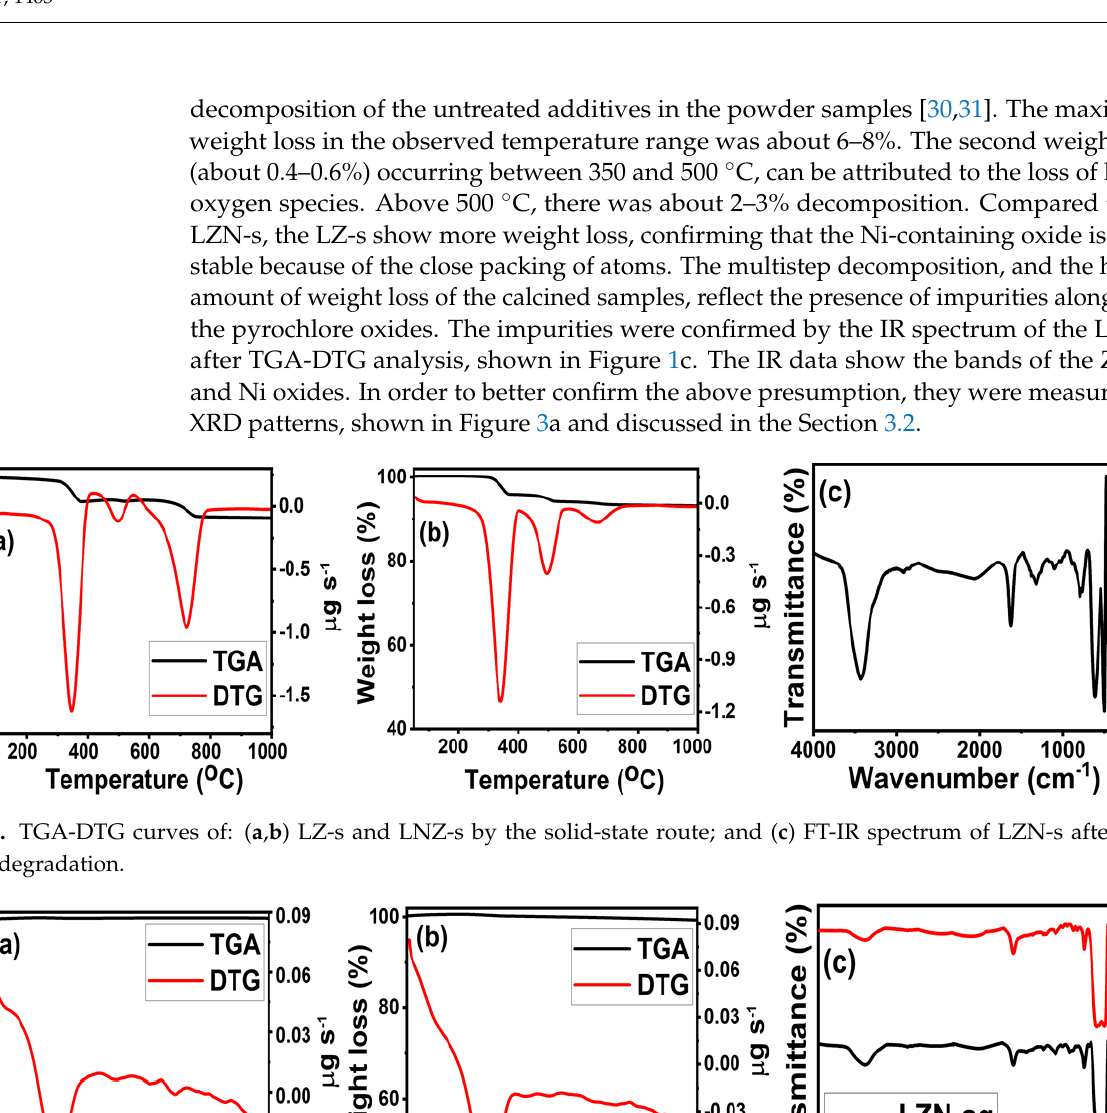
Figure 3. XRD patterns of La 2 Zr 2-x Ni x O 7 (x = 0.0, 0.5) fabricated by the ( a ) solid-state and ( b ) sol-gel routes. 3.2. Crystal Structural Analysis by XRD The powder XRD was used to recognize the phase purity and crystalline structure of the fabricated La 2 Zr 2-x Ni x O 7 , depicted in Figure 3. The XRD patterns of LZ-s and the LZN- s pyrochlores fabricated by the solid method are shown in Figure 3a. It was observed that the peaks corresponding to the base pyrochlore cubic structure, instead of the fluorite phase, were detected in both samples. However, other phases also segregated, such as the perovskite phase (LaZrO 3 ) and the NiO phase, in addition to the cubic phase [6]. The peaks of the (200) and (220) NiO phases, at 2θ values of 43.4° and 63.05° , respectively, were ob- served in the LZN-s sample. The (200) plane of NiO coincides with the low-intensity (511) plane of the pyrochlore [7]. This divulges that the chosen temperature and decomposition time (6 h and 1200 °C) were insufficient to grow into the pyrochlore structure; it needed more heat and time for the complete transformation.